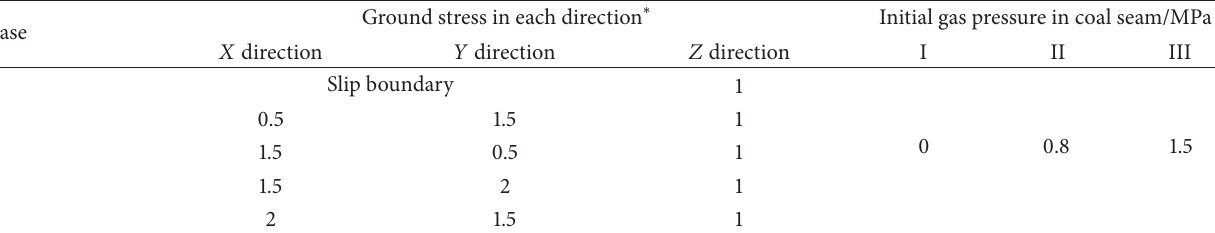
Table 2: Conditions of ground stress and coal gas in the